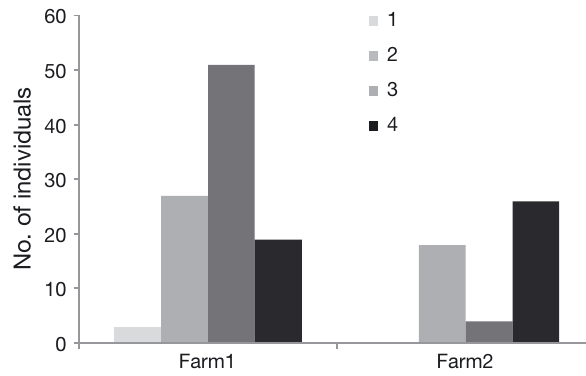
Fig. 3. Gonadic maturation stages (1 = immature, 2 = matur- ing, 3 = running and 4 = spent) in farmed Atlantic cod sam- ples (mean age = 2.4 yr). Both samples were taken in 2009; Farm1 in March and Farm2 in